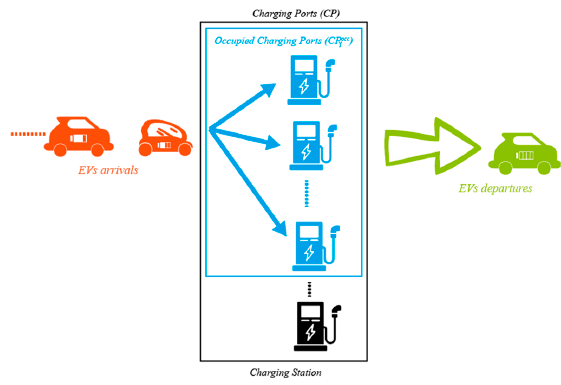
Figure 6. Queueing process.